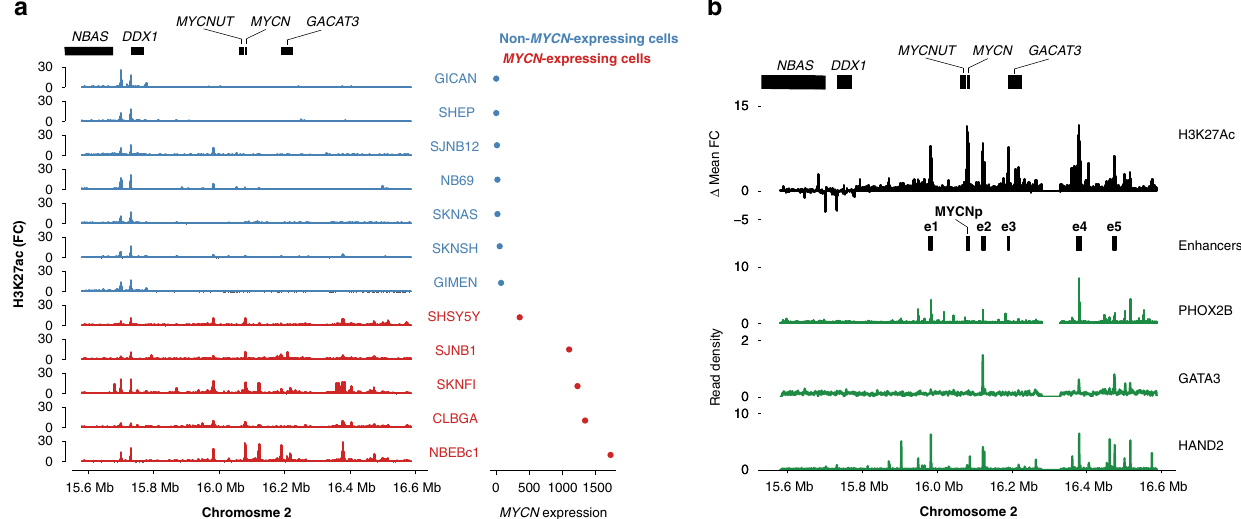
Fig. 1 Five enhancers are speci fi cally found in MYCN -expressing neuroblastoma cells. a H3K27ac ChIP-seq fold change over input (left) and size-factor normalized MYCN expression as determined from RNA-seq for 12 non-MYCN-ampli fi ed neuroblastoma cell lines. b Aggregated H3K27ac signal of MYCN - expressing compared to non-expressing cells (top, black; MYCNp, MYCN promoter; e1 – e5, MYCN -speci fi c enhancers). PHOX2B, GATA3, and HAND2 core regulatory circuit transcription factor ChIP-seq in an MYCN -expressing neuroblastoma cell line (green, CLB-GA). Source data are provided as a Source Data fi